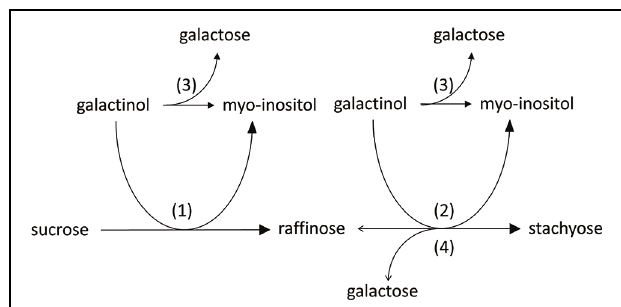
FIGURE 6 | Enzyme activities of recombinant AtRS4. Recombinant AtRS4 annotated as putative StaS (AtSTS, AtRS4, At4g01970) shows in HPAEC-PAD enzyme assays RafS (1), high affinity StaS (2) as well as Sta (4) and Gol (3) specific galactosylhydrolase enzyme activity.